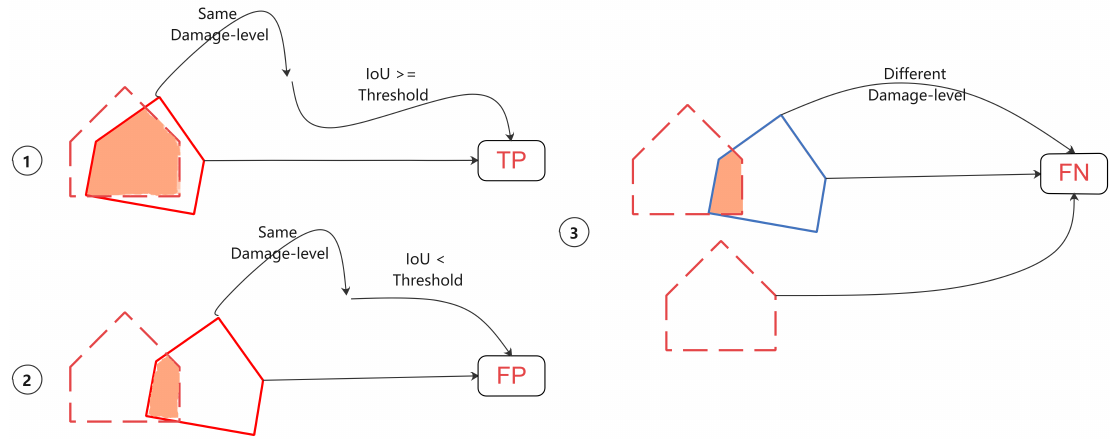
Figure 10. With a given IoU for building contour segmentation, we can define the True Positive (TP), False Positive (FP), and False Negative (FN) to evaluate the detection result. The IoU threshold decides the precision of localization